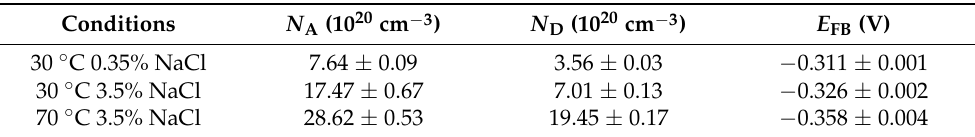
Figure 6. The Mott–Schottky curves for the films on Fe-based AMCs samples in NaCl solution with various concentration and temperatures. Table 3. Doping density and flat band potential E FB of the films on Fe-based AMCs at different solution conditions.